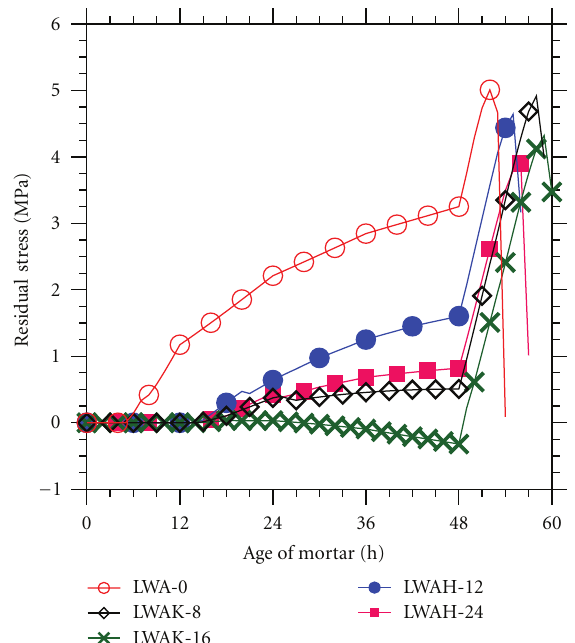
Figure 7: Calculated residual stress development in dual ring specimens when cooling began after